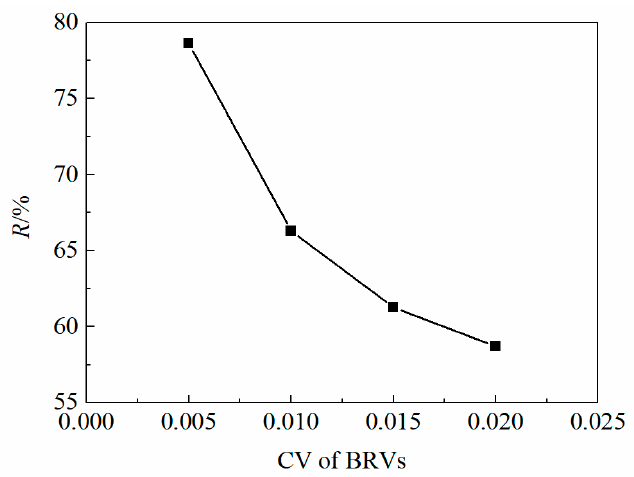
Figure 7. The correlation curve between the R of Composition B and the CV of the BRVs under the shock load condition where v is 1050 m/s.